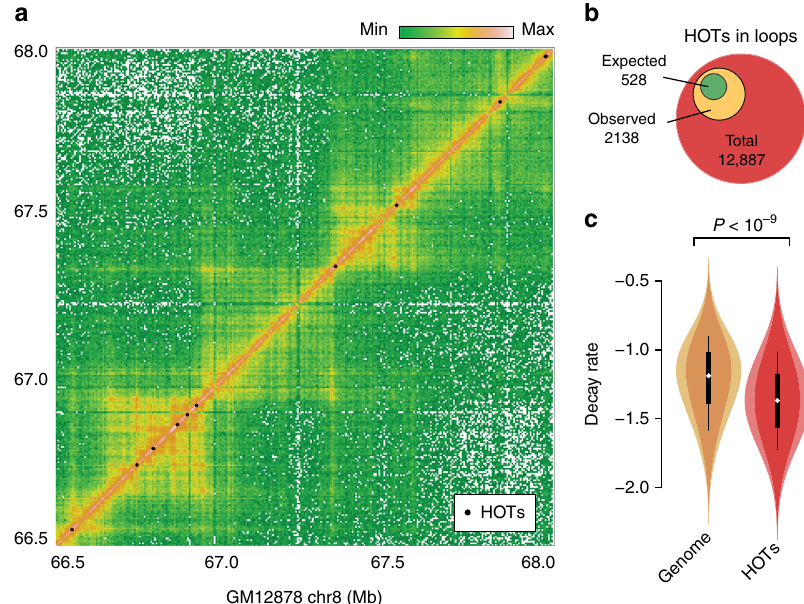
Fig. 6 Highly occupied targets in the human genome. a Hi-C map of the human cell line GM12878, along with the position of the highly occupied targets (HOTs) indicated by black dots. b HOTs are enriched at chromosomal loops in GM12878. The location of the HOTs from Foley and Sidow 30 was crossed with the location of the loops from Rao et al. 30,31 . Out of 12,887 HOTs, 2138 were found in loops versus 528 expected (binomial distribution P < 10 − 9 ). c HOTs are located in uncompacted chromatin. The violin plots show the distribution of contact decay in 50 kb windows in the whole genome versus each HOT. The mean values are − 1.22 and − 1.37, respectively (95% con fi dence interval for the difference 0.146 – 0.157, Student ’ s t test with Welch – Satterthwaite correction and 18,080 degrees of freedom P < 10 − 9 ). The white dot inside each violin represents the median of the distribution. The black block ranges from the fi rst to the third quartile and the whiskers range from the fi rst to the ninth